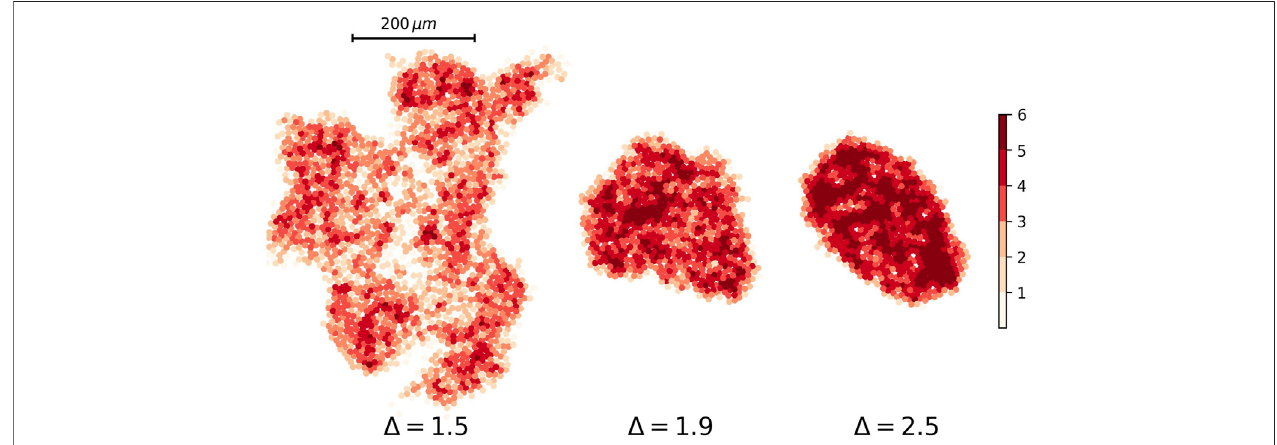
FIGURE 10 | Heat plot of nodes ’ degree for three different tumor networks. The attraction strength for tumors are Δ = 1.5, Δ = 1.9, and Δ = 2.5 from left to right respectively. The attraction range for all of them are the same, σ = 1.5.